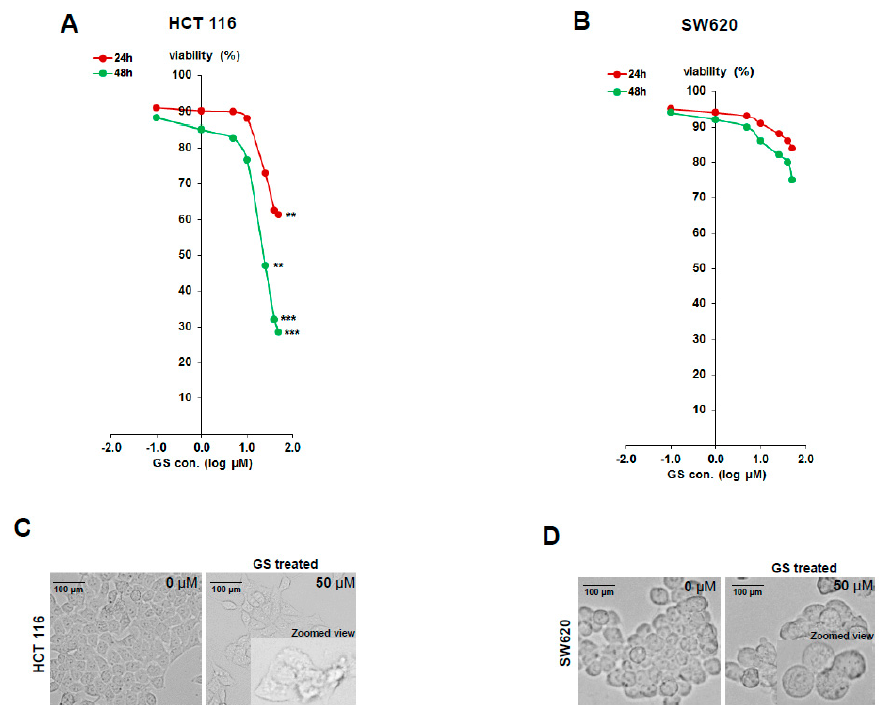
Figure 1. Guggulsterone inhibits proliferation of HCT 116 cells. Cell viability was determined in HCT 116 and SW620 cells after 24 and 48 h of incubation with varying concentration of Guggulsterone (GS). Viable cell counts were determined by MTT (3-(4,5-dimethylthiazol-2-yl)-2,5-diphenyltetrazolium bromide) assay. Plots show dose- and time-response of ( A ) HCT 116 and ( B ) SW620 cells % viability with GS treatment. Data are presented as mean ± SD ( n = 6). Significance was calculated using Student’s t -test; ** p < 0.005, *** p < 0.003. ( C , D ) E ff ect of GS treatment on morphology of colorectal cancer cell lines. HCT 116 cells (C) and SW620 (D) were treated with GS (50 µ M) for 48 h. Images were captured under a light microscope under 40 × magnification. Zoomed in image is attached in frame of GS treated picture plate. GS treatment resulted in significant morphological changes in HCT 116 cells with loss of cell integrity as well as blebbing compared to the untreated intact